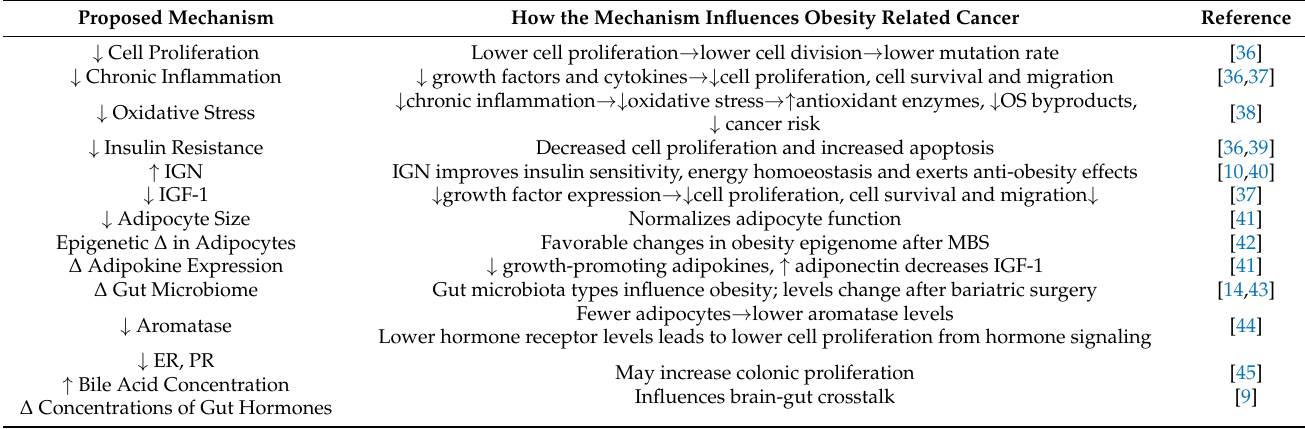
Table 3. Mechanisms possibly linked to cancer risk reduction or